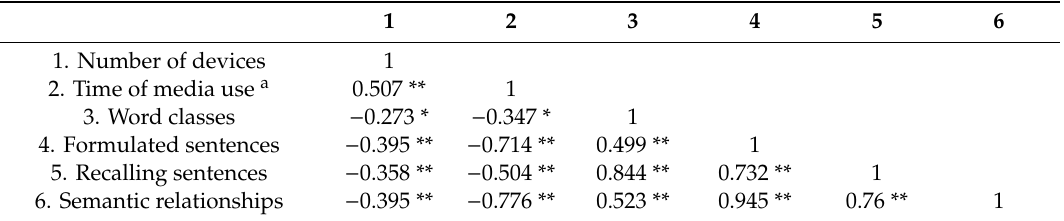
Table 4. Spearman correlations between the number of devices, time of media use, and language scores.